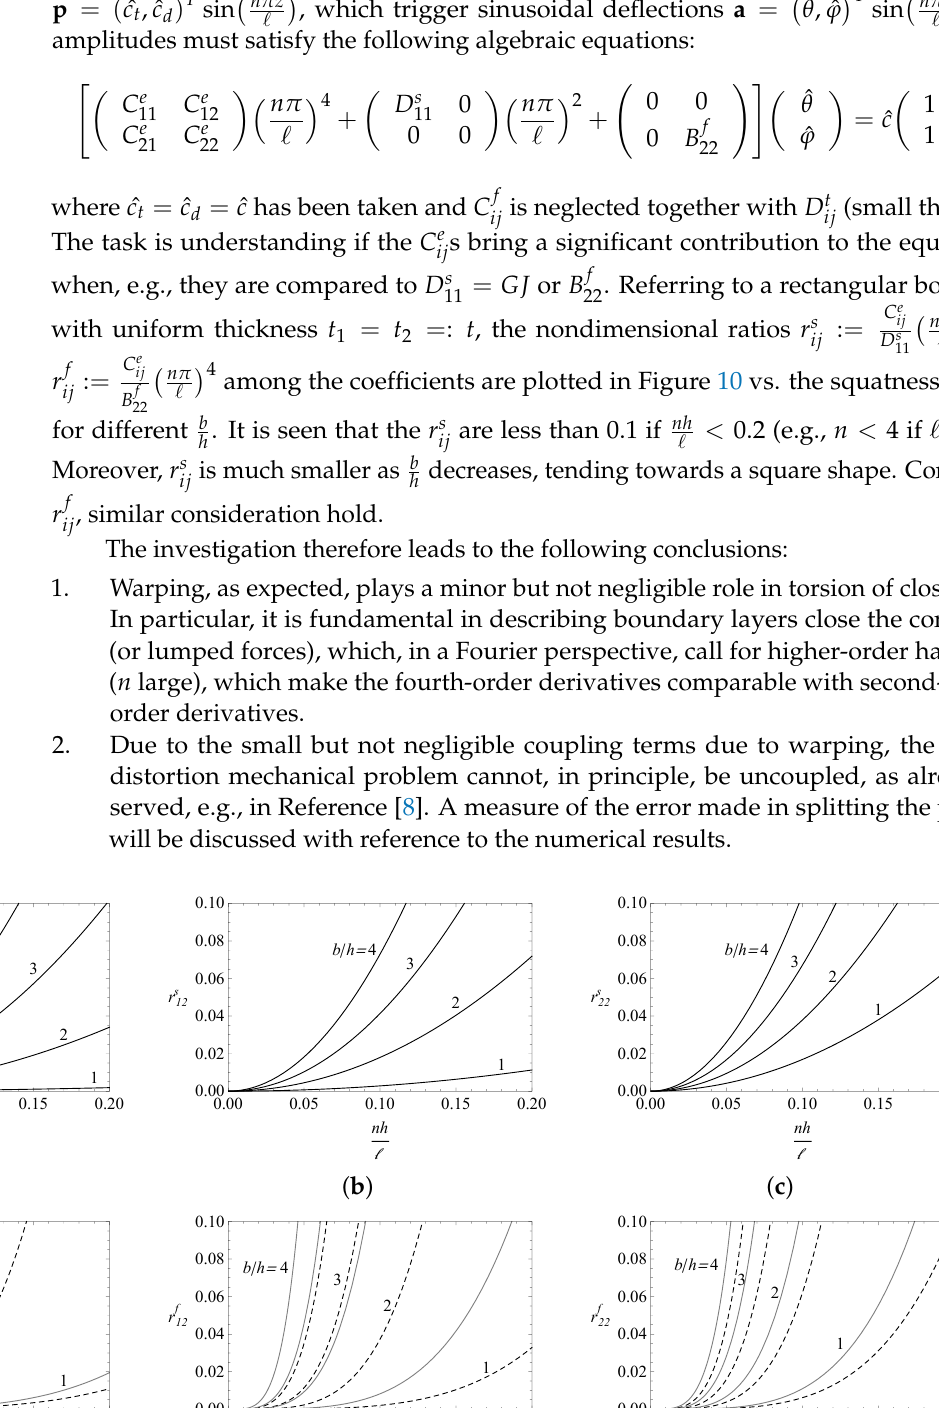
C e ij (cid:0) n π (cid:1) 2 : = ; (cid:96) ij GJ = 6 (black ; h t 1 h